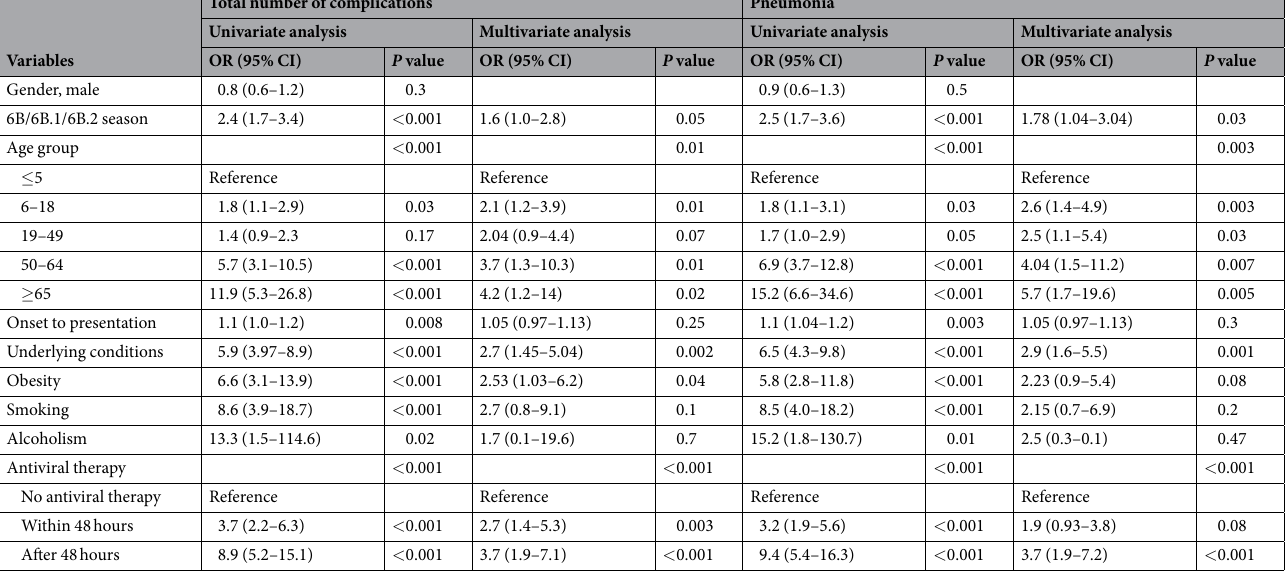
Table 4. Logistic Regression Analysis of the Risk Factors Associated with Complications and Pneumonia among Patients with Influenza A(H1N1)pdm09 Virus Infection.